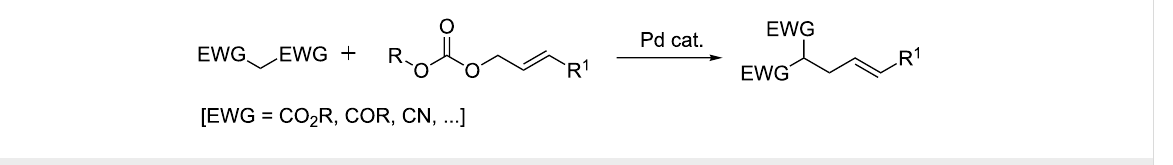
Figure 1: Complexes and ligands employed.